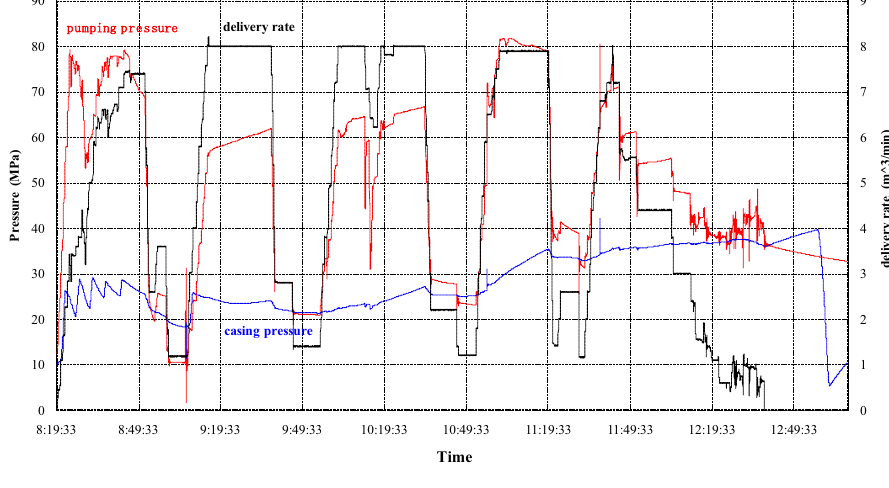
Fig. 6 The plot of gas well MX—A acid fracturing